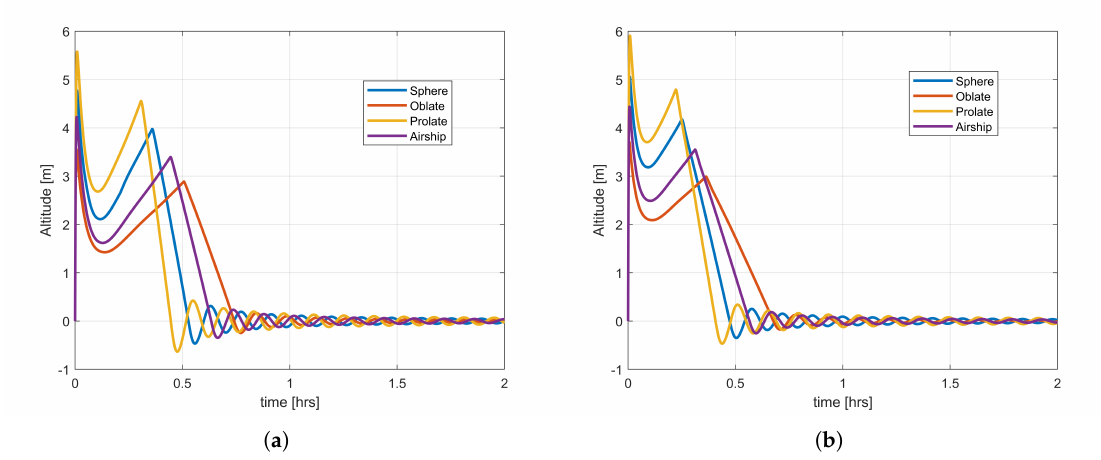
Figure 13. Ascent speed variation of different balloon types at a particular fineness ratio on Mars ( a ) SP ( b ) OZP. A fineness ratio of 0.4 for airship and 0.4 for prolate and airship, and 4 for oblate shape is